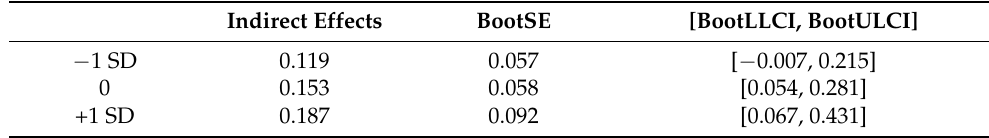
Table 6. Results of the mediated moderation model.